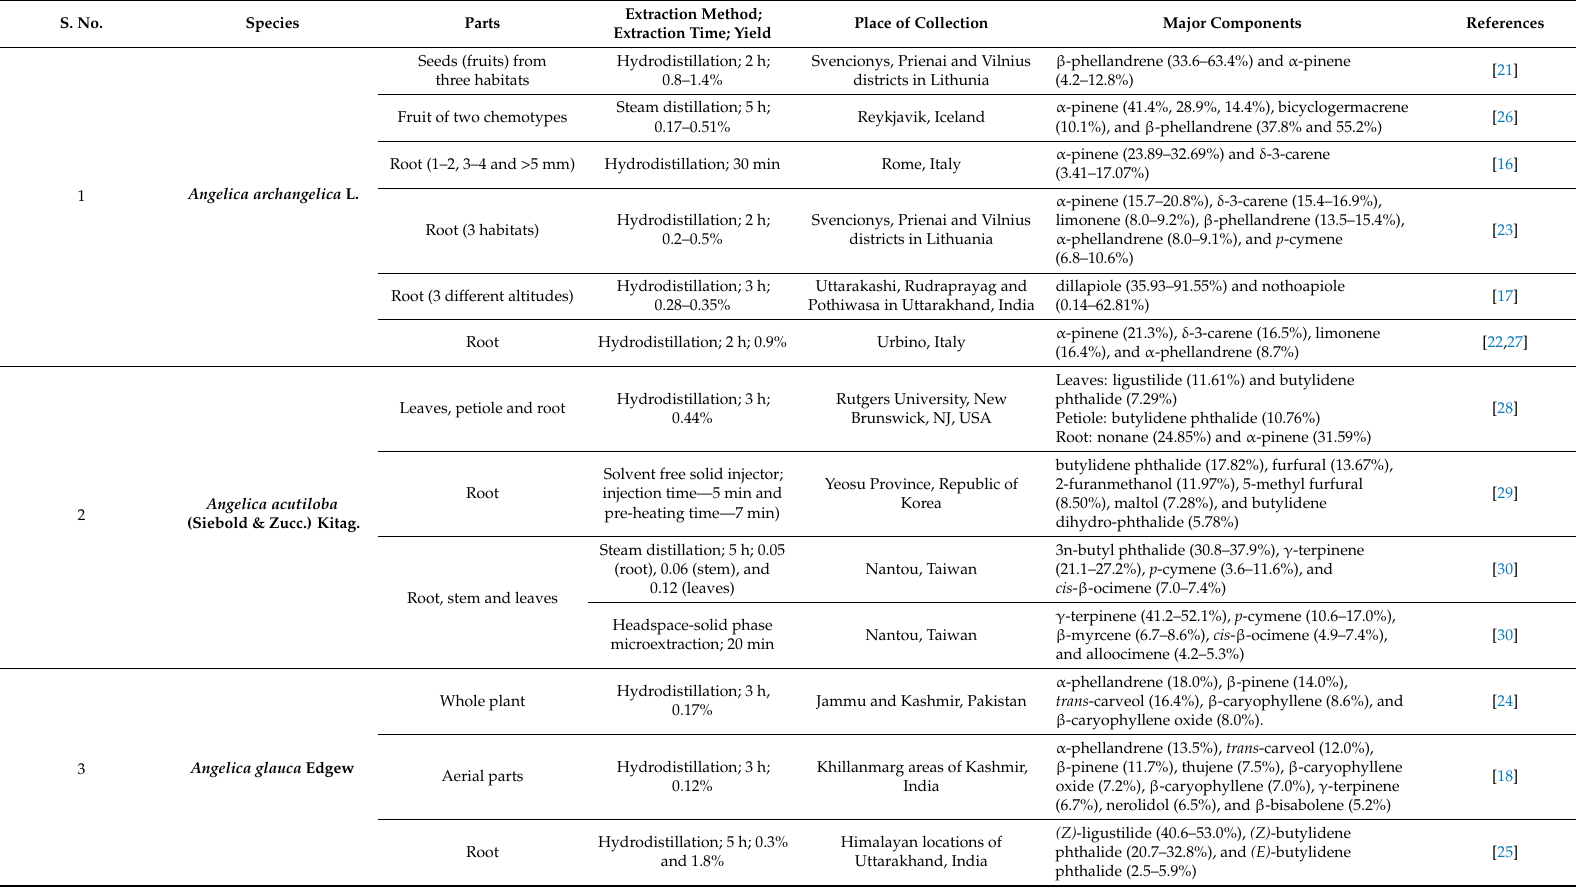
Table 1. The isolation of essential oils and extracts from different Angelica species, and their major